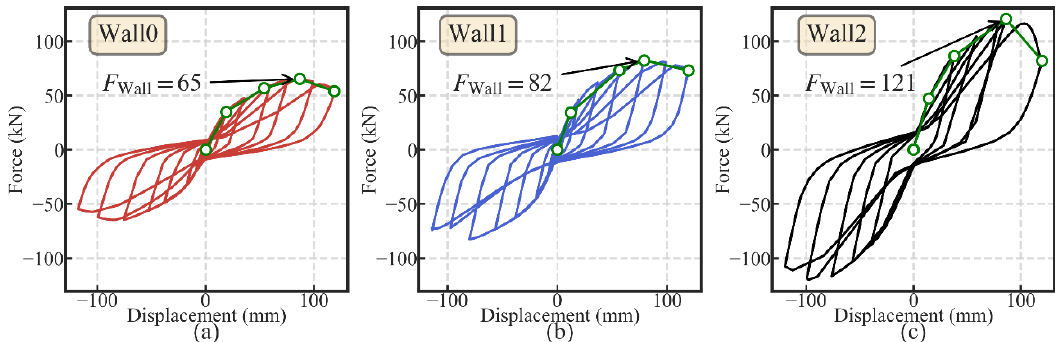
Figure 11. Hysteretic curves of the three light frame wood shear walls ( a ) wall 0; ( b ) wall 1; and ( c ) wall 2.